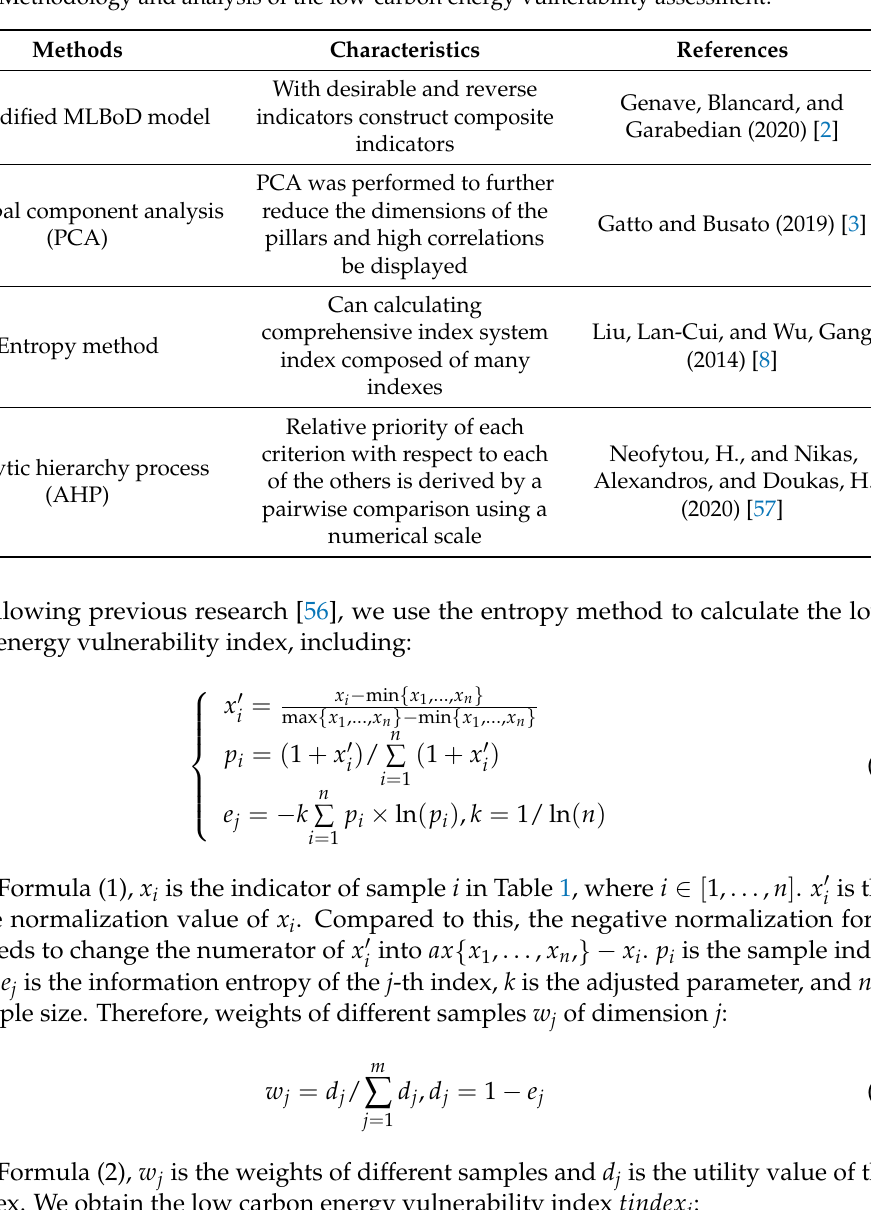
Table 2. Methodology and analysis of the low-carbon energy vulnerability